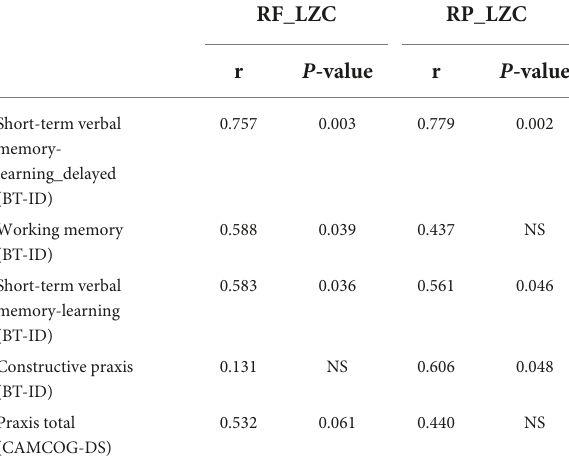
TABLE 5 Spearman correlation coefficients (r) and p -values between neuropsychological variables and LZC values within the MCI-DS